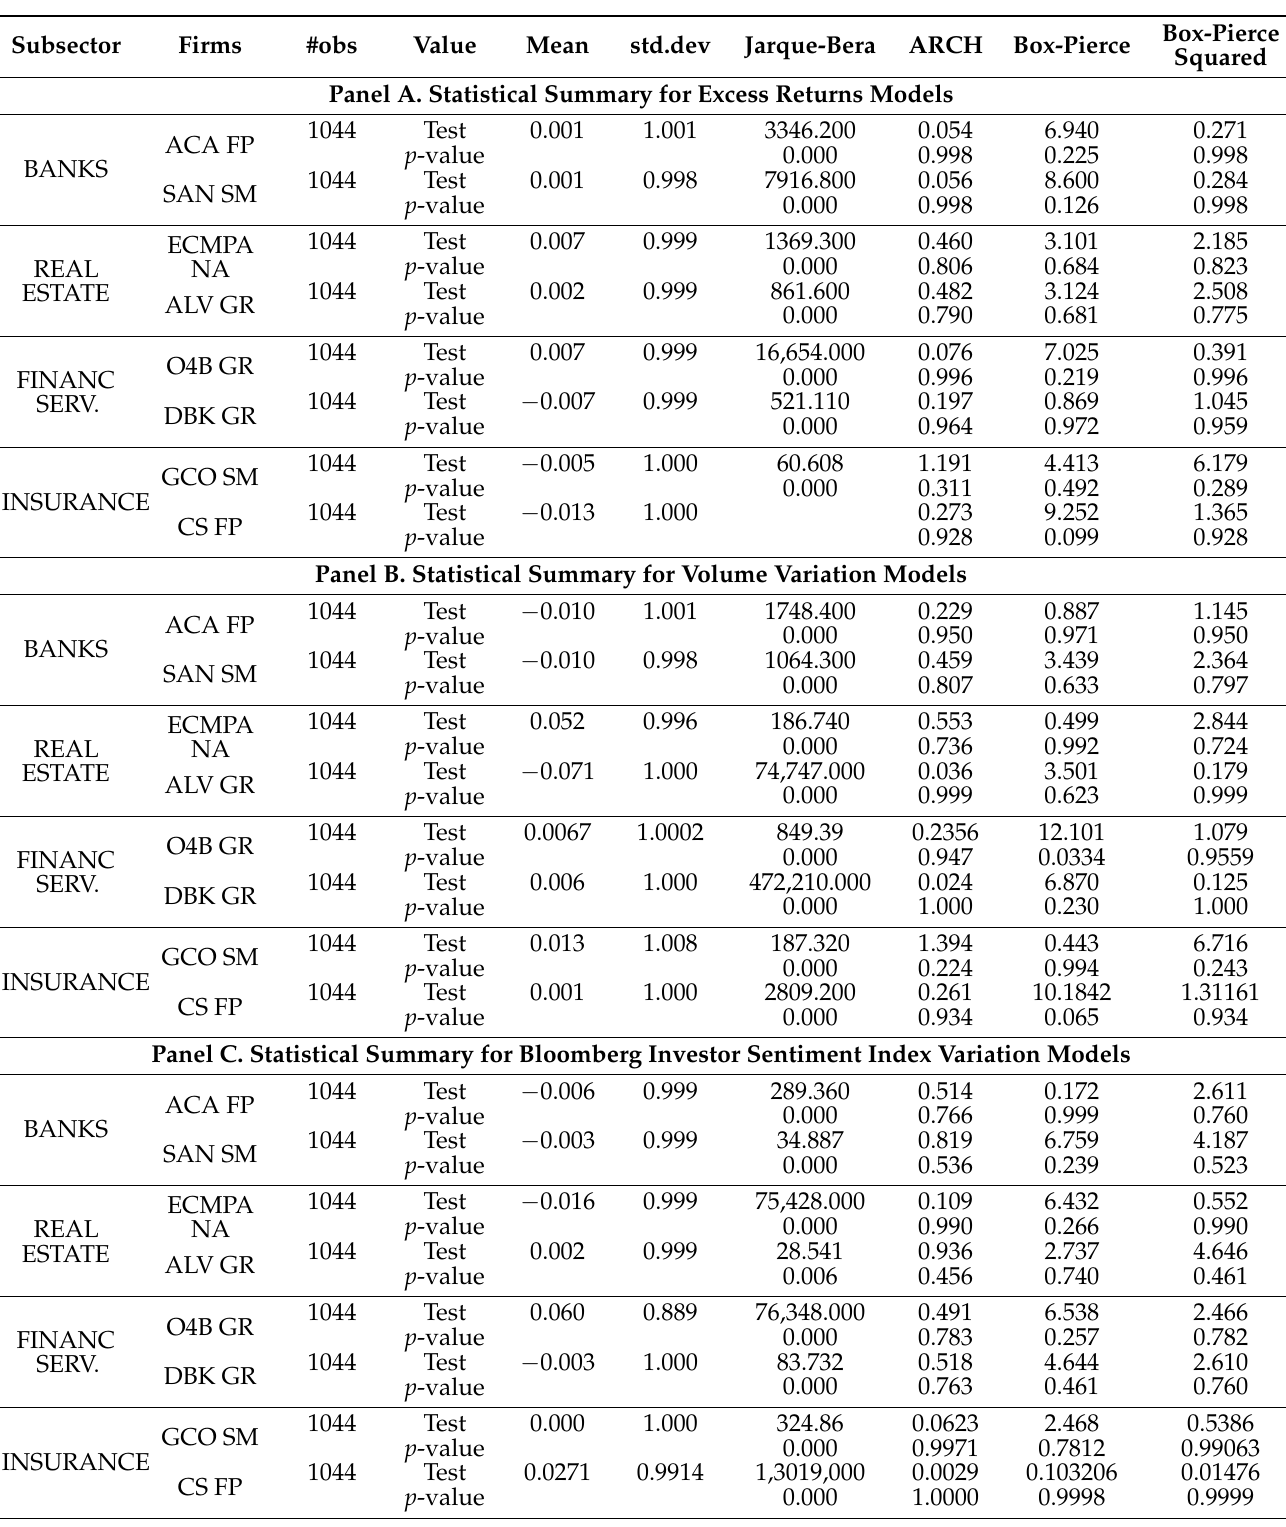
Table 3. Statistical summary of standardized